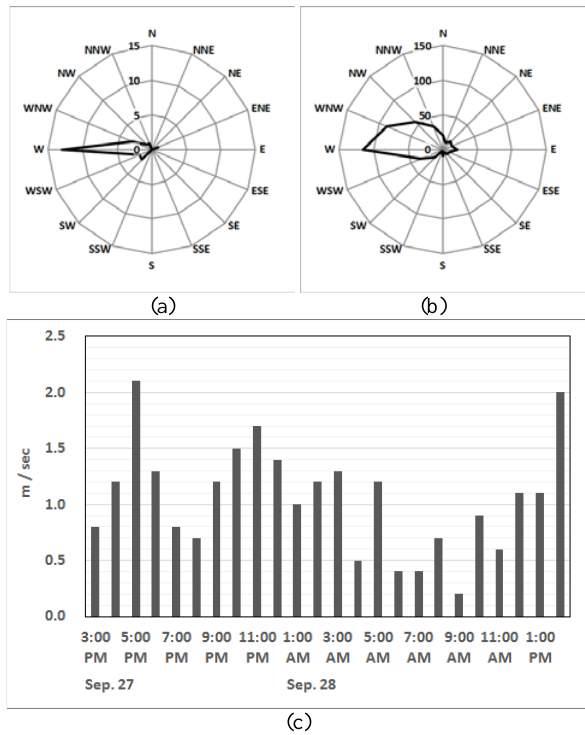
Figure 7. Weather data after the leakage: (a) wind directions during 24 hours after the leakage, (b) wind directions during 21 days after the leakage and (c) wind speeds during 24 hours after the